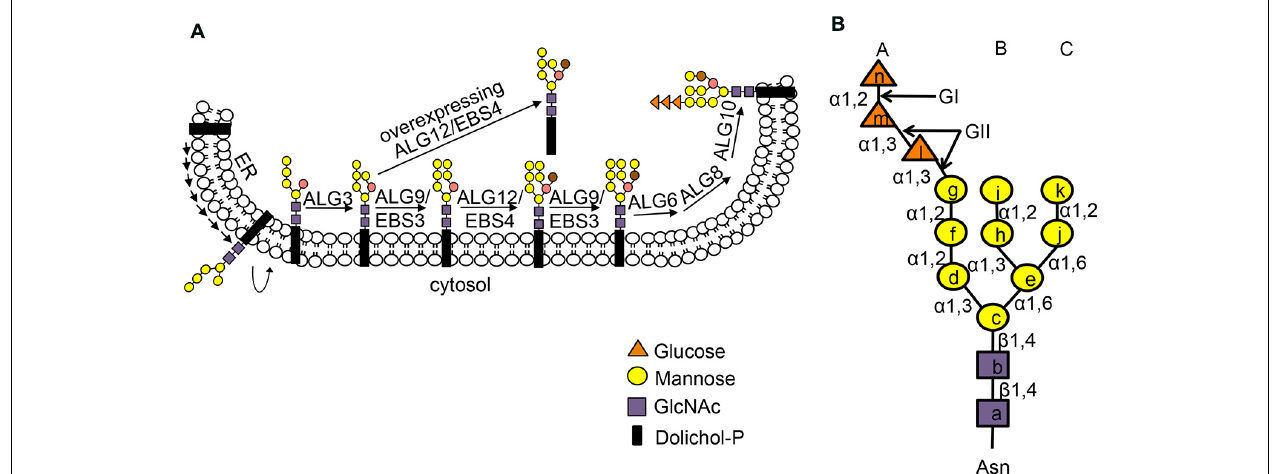
FIGURE 1 | (A) Stepwise assembly of N -glycan precursor on the ER membrane. The assembly of the N -glycan precursor starts at the cytosolic face of the ER membrane by adding two GlcNAc and five Man residues to the membrane-anchored Dol-PP linker. The resulting Dol-PP-Man 5 GlcNAc 2 flips over into the ER lumen. Four Man residues are sequentially added to the flipped Dol-PP-Man 5 GlcNAc 2 by three mannosyltransferases, ALG3, ALG9 (known as EBS3 in Arabidopsis ) and ALG12 (known as EBS4 in Arabidopsis ) with the ALG9 catalyzing two reactions of adding the terminal α 1,2 Man residues on the middle and